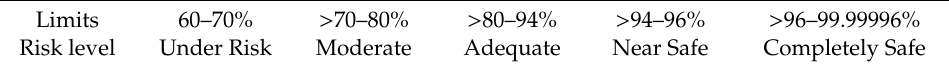
Table 11. The Lean Safety Performance Level reference